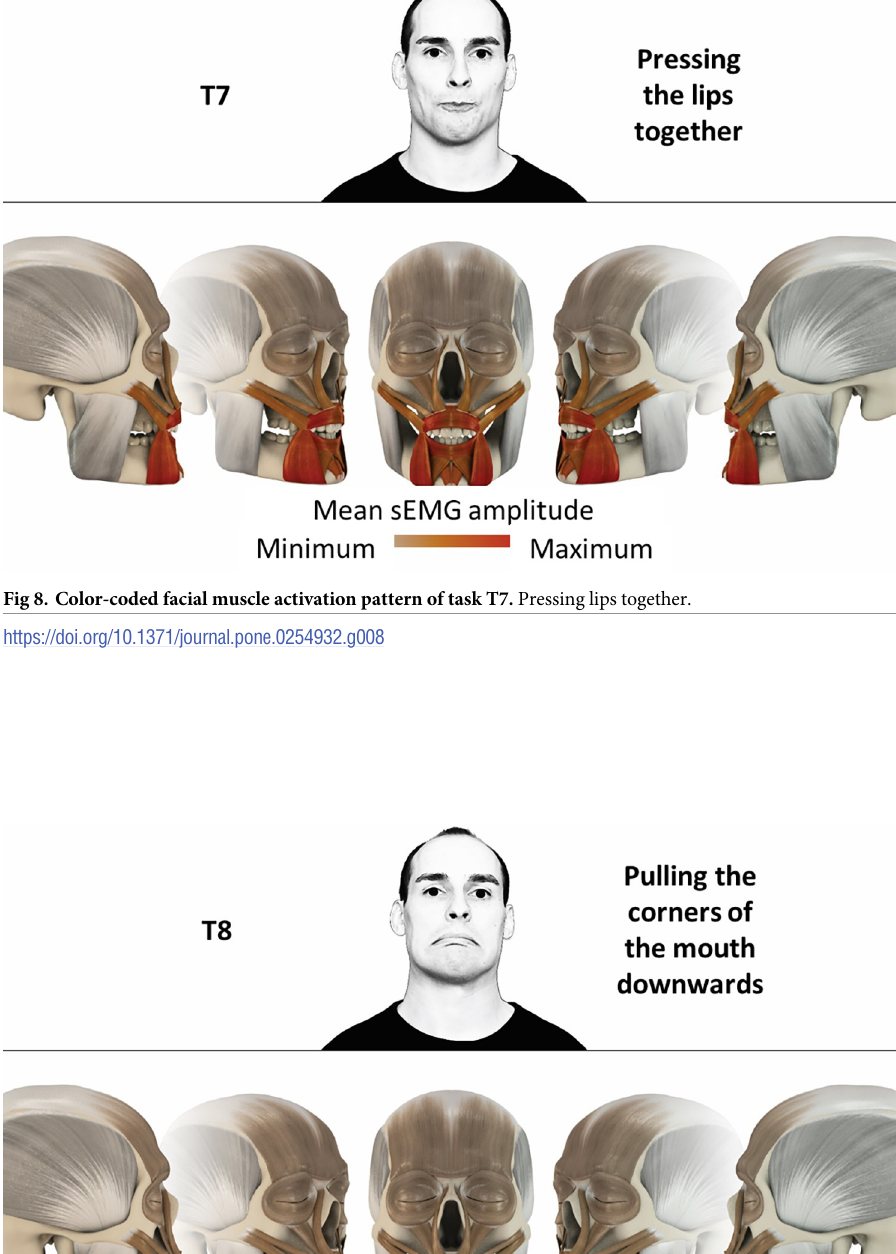
PLOS ONE | https://doi.org/10.1371/journal.pone.0254932 July 19,